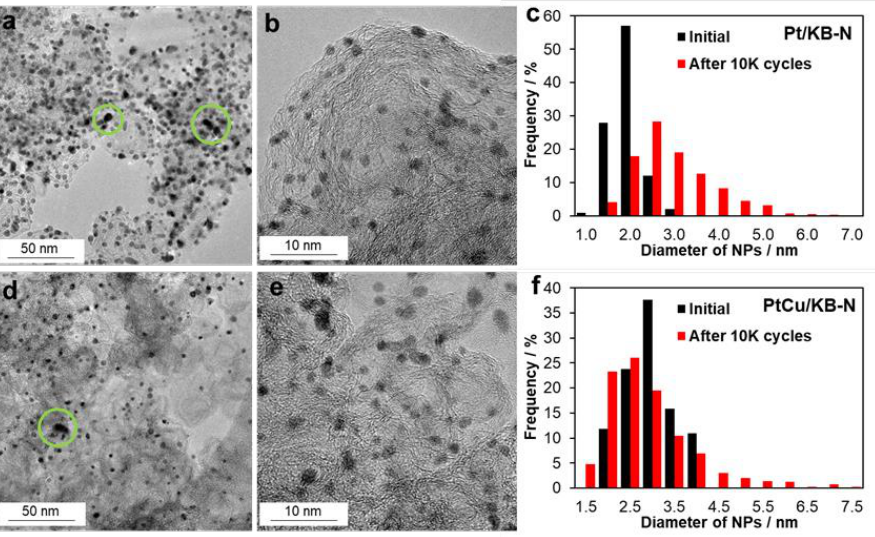
Figure 7. TEM of the Pt/KB-N ( a , b ) and PtCu/KB ( d , e ) samples after the stress test. Size distribution histograms of the corresponding materials before and after the stress test ( c , f ).